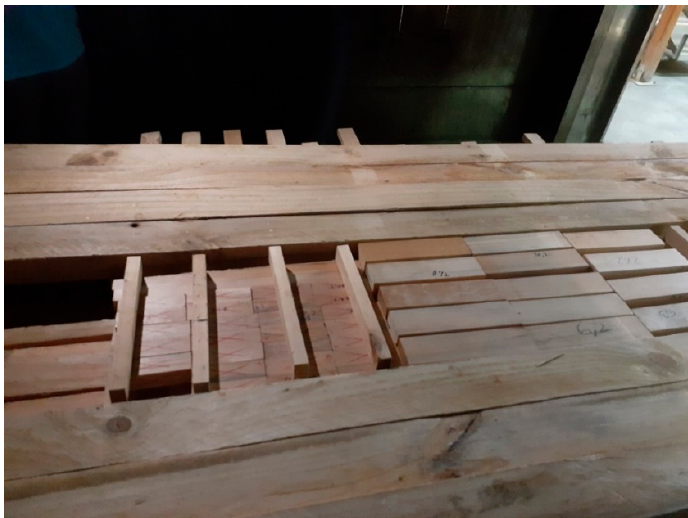
Figure 1. Stacking of Pinus oocarpa specimens within the drying pile .